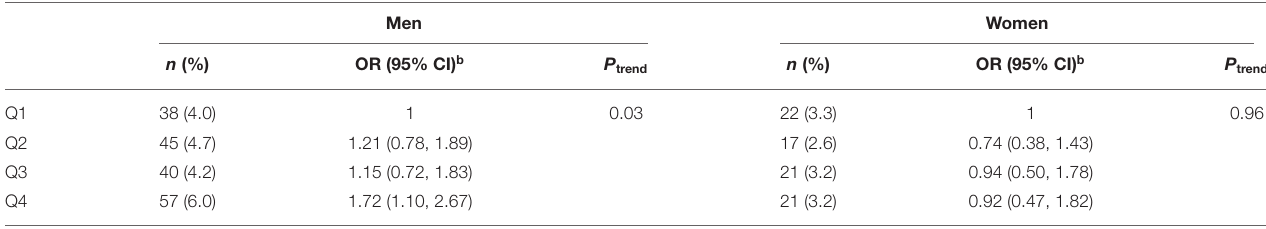
TABLE 4 | Adjusted odds ratios and 95% confidence interval for the association between energy-adjusted dietary inflammatory index (E-DII) quartile a and > 3 mg/L of high-sensitivity C-reactive protein (hs-CRP).